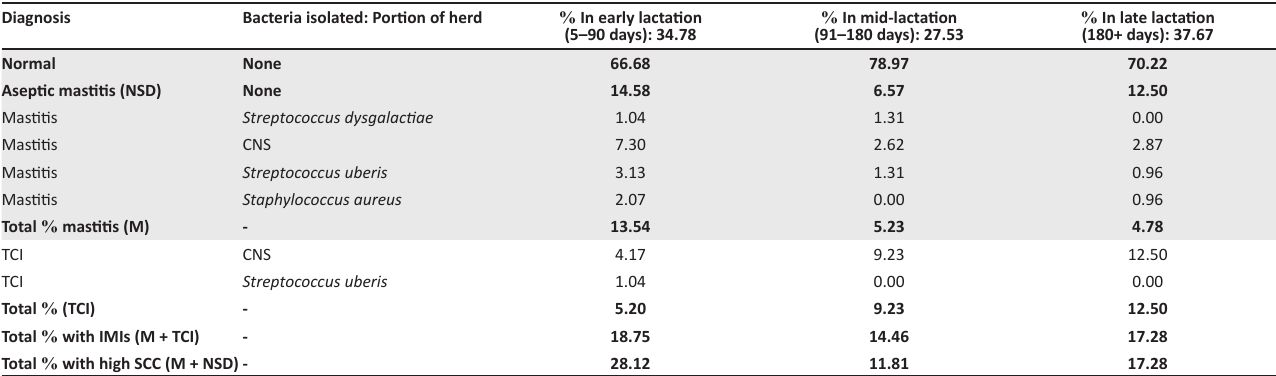
TABLE 4: Herd Udder Health status correlated with different stages of lactation using quarter milk samples.